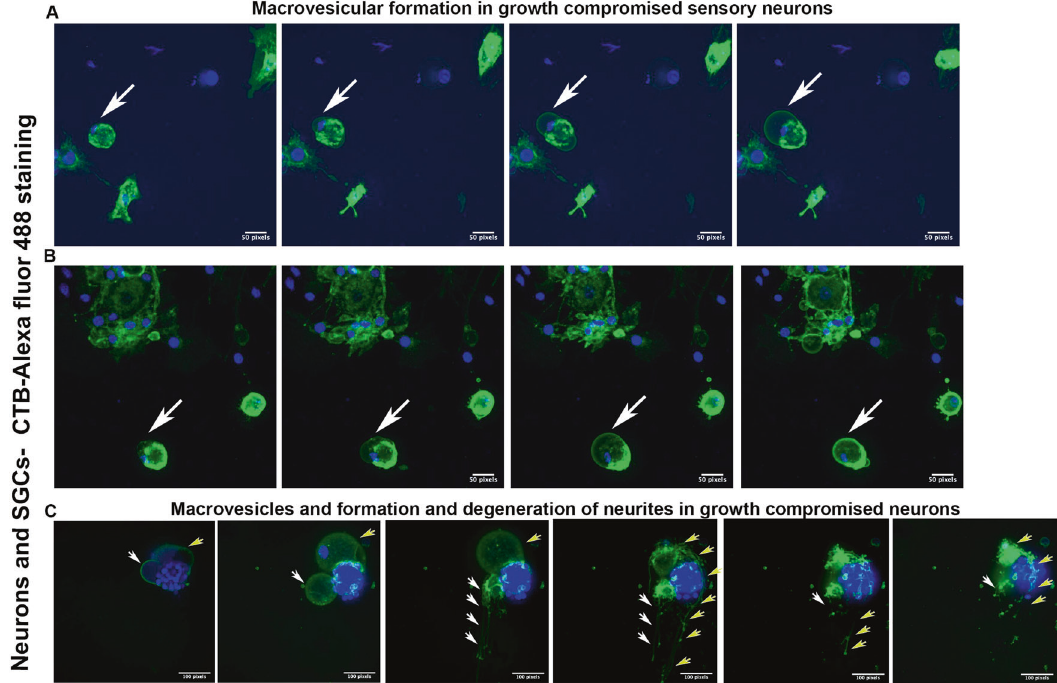
Fig. 4 Macrovesicular formation and unstable neurite formation in growth compromised neurons. A , B Snapshots of the videos (Video 1 and the Supplementary Video 1) generated from overnight time-lapse confocal images of primary sensory neurons grown on PLL coated, but laminin deprived surfaces show macrovesicular formation (arrows). The neurons were stained with Cholera toxin-B conjugated with Alexa fl uor-488 (green) and Hoechst (nuclear stain: blue) for the live cell imaging. C Snapshots of Video 2 generated from similar cultures as in A and B show unstable neurites emerging from the macrovesicular structures followed by rearrangement of neuronal cytoskeleton. Two events of macrovesicular formation and fates are shown using white and yellow arrows. [Bar calibration is 2.24